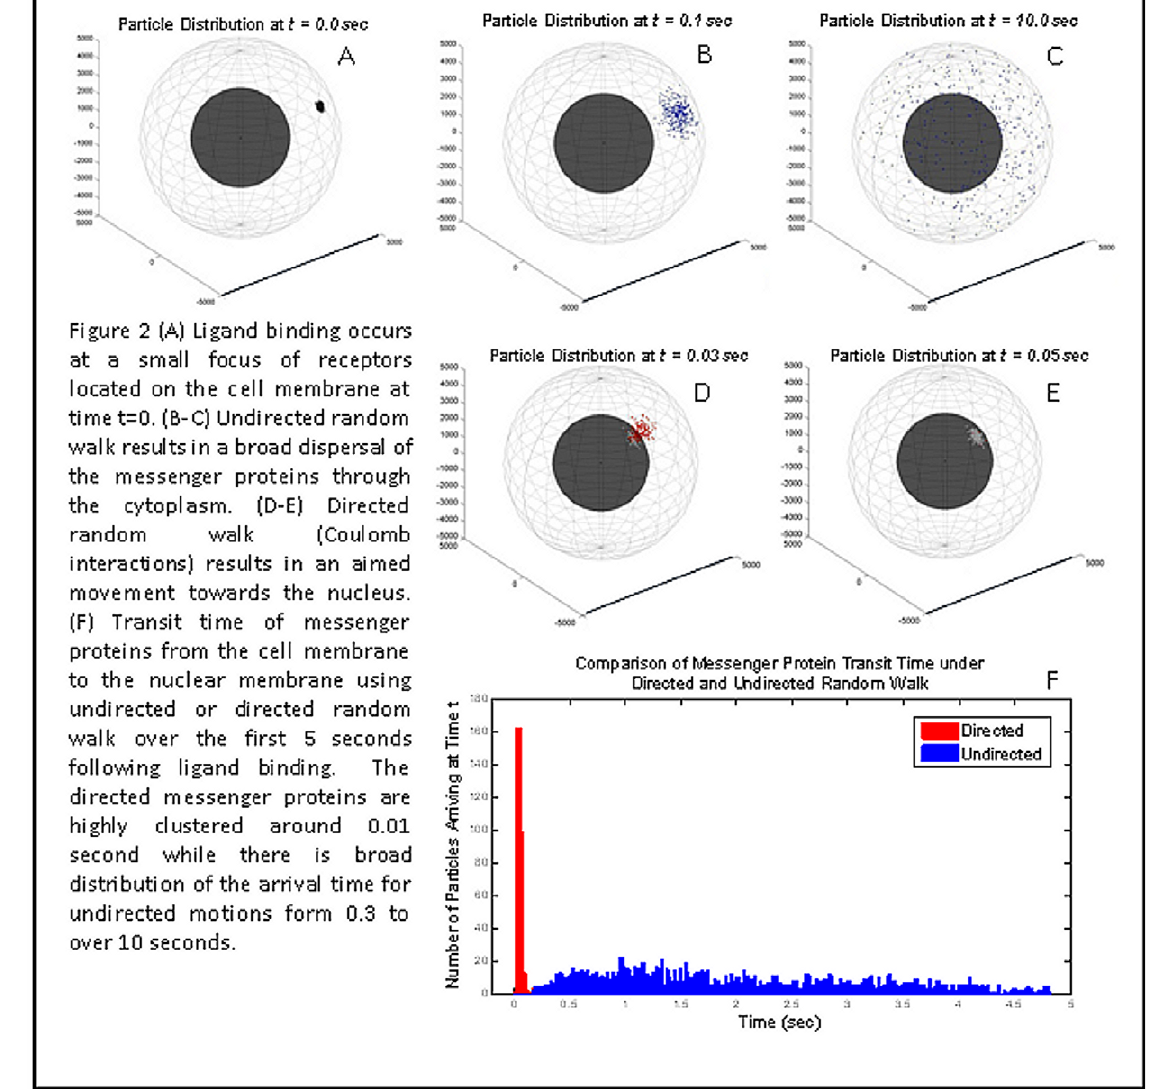
Figure 2. Diffusion of messenger proteins resulting from ligand binding to a small focus of receptors on the cell membrane at time t=0. By random walk (top panels), there is broad dispersal of the messenger proteins through the cytoplasm. As a result, all information regarding the time and location of ligand binding is lost. By biased random walk (lower panels) due to Coulomb interactions of phophorylated, negatively charged messenger proteins with an intracytoplasmic electric field, the spatial location of ligand binding on the CM is projected onto the NM and the transition time is less than 0.1 second.